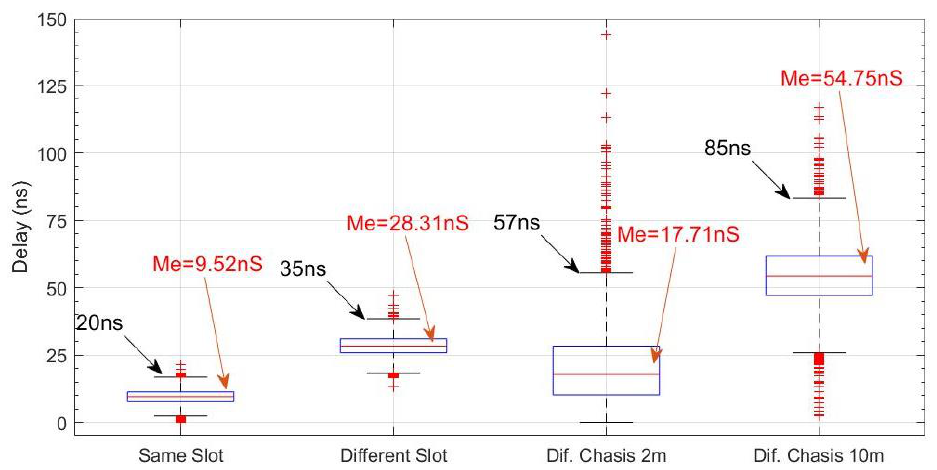
Figure 7. Box-and-whisker plot for Sigma-Delta converter tests.